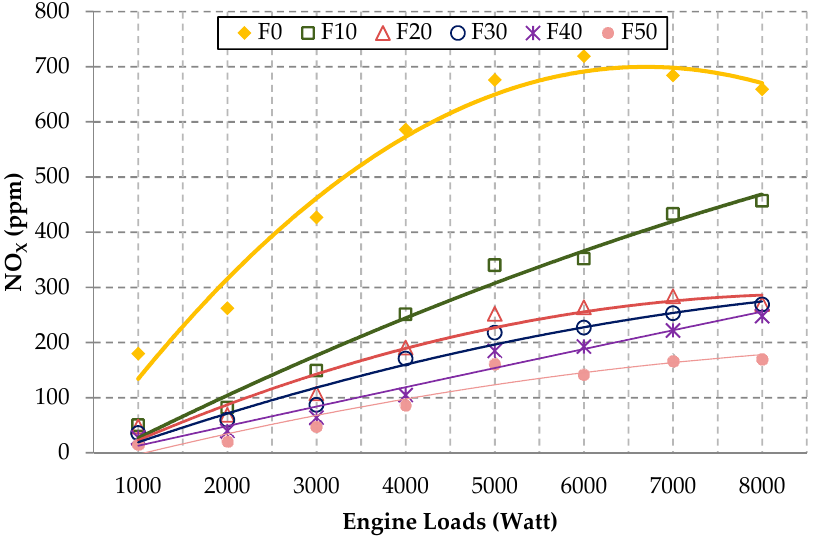
Figure 9. NOx emission changes with engine loads.